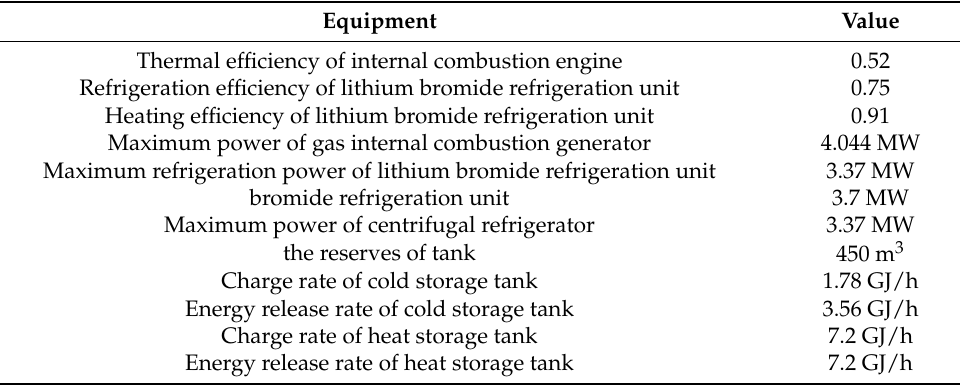
Table 3. System equipment